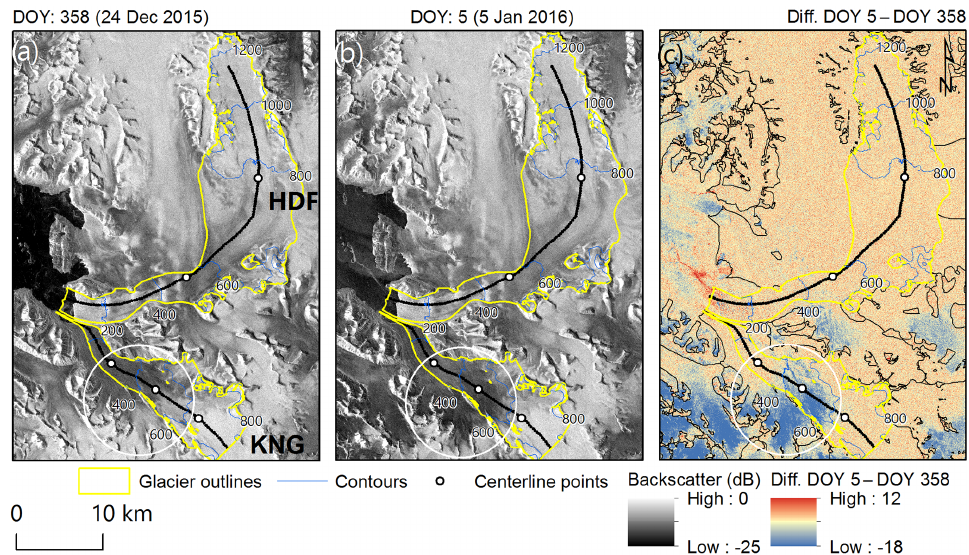
Figure 8. (a) Sentinel-1A backscatter (dB) image from 24 December 2015 (DOY 358) and (b) the following Sentinel-1A backscatter image from 5 January 2016 (DOY 5) showing remnants of the rain event. (c) The difference between 5 January 2016 (DOY 5) and 24 December 2015 (DOY 358) SAR intensity images. Blue color indicates a lowering of backscatter values between the images, showing wetter conditions in the upper firn of Kongsvegen (white circles). Glacier outlines from 2007 (Nuth et al.,